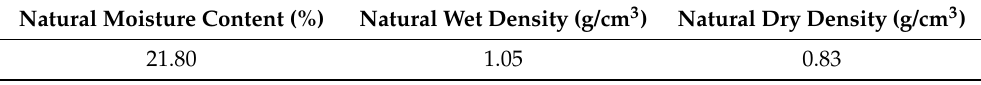
Table 1. Basic physical properties of the soil samples. Natural Moisture Content (%)